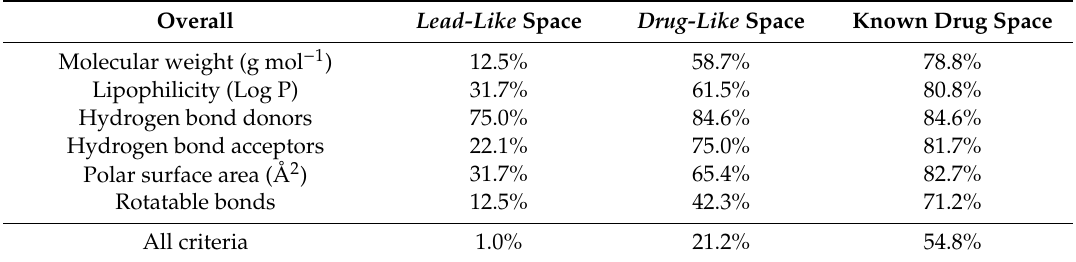
Table 4. Compounds from Animalia and their inclusion within the defined chemical